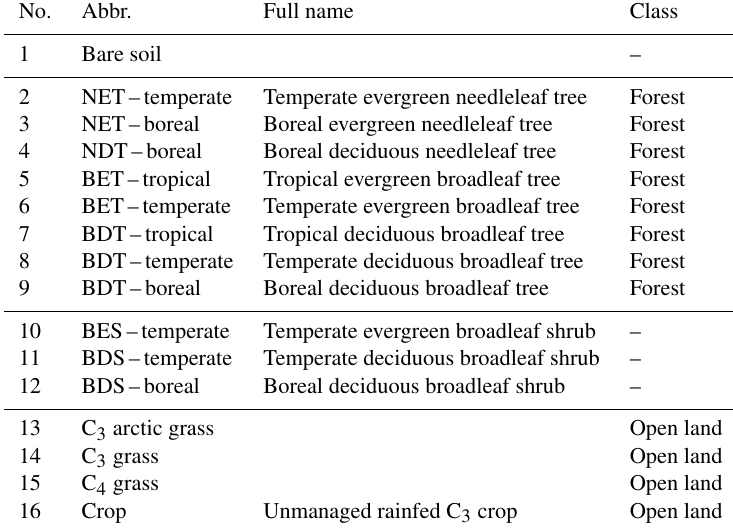
Table A2. The default PFT classification in